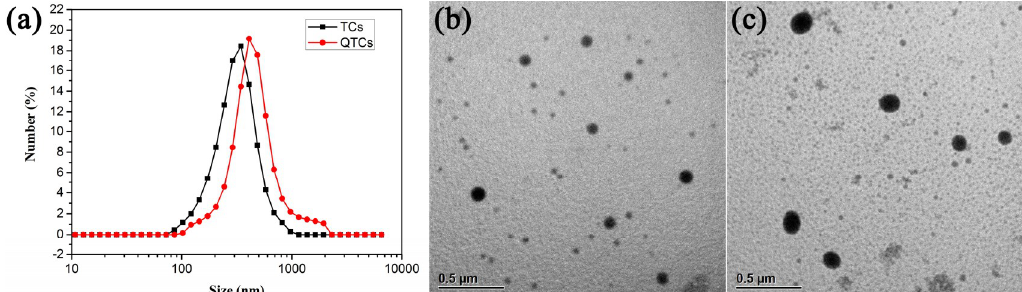
Figure 3. Characterization of TCs and QTCs. ( a ) Particle size distribution of TCs and QTCs measured by dynamic light scattering, transmission electron microscope (TEM) images of ( b ) TCs and ( c ) QTCs.